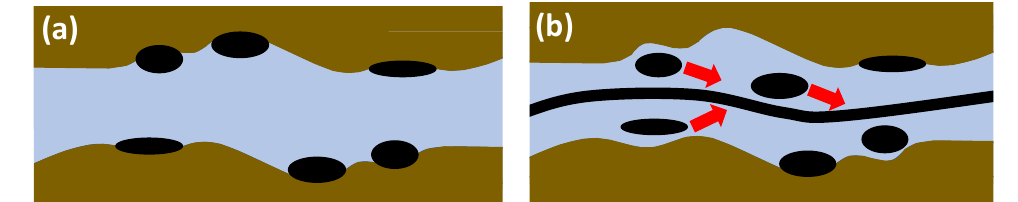
Figure 20. ( a ) Situation after conventional water flooding. The oil is left as isolated oil drops; ( b ) viscoelastic polymer solution is injected resulting in the formation of an oil thread along which the oil upstream flows along and build-up an oil bank downstream.